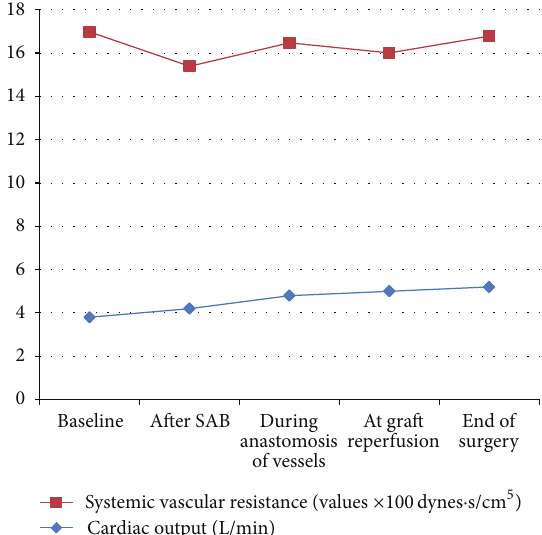
Figure 2: Intraoperative haemodynamics. (Values are mean of readings of eight patients.) SAB: subarachnoid